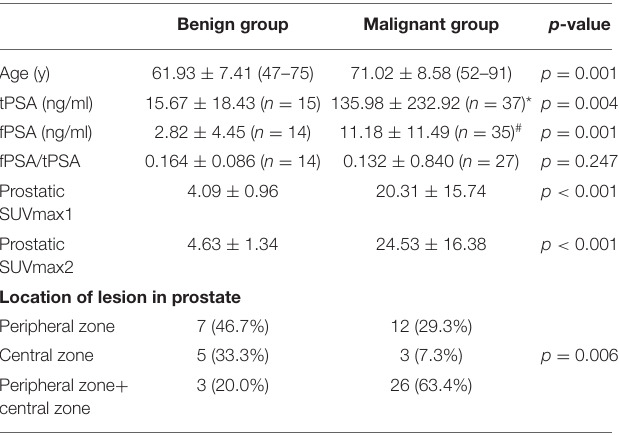
TABLE 1 | Patient characteristics and prostatic features in benign group and malignant group. Benign group Malignant group p